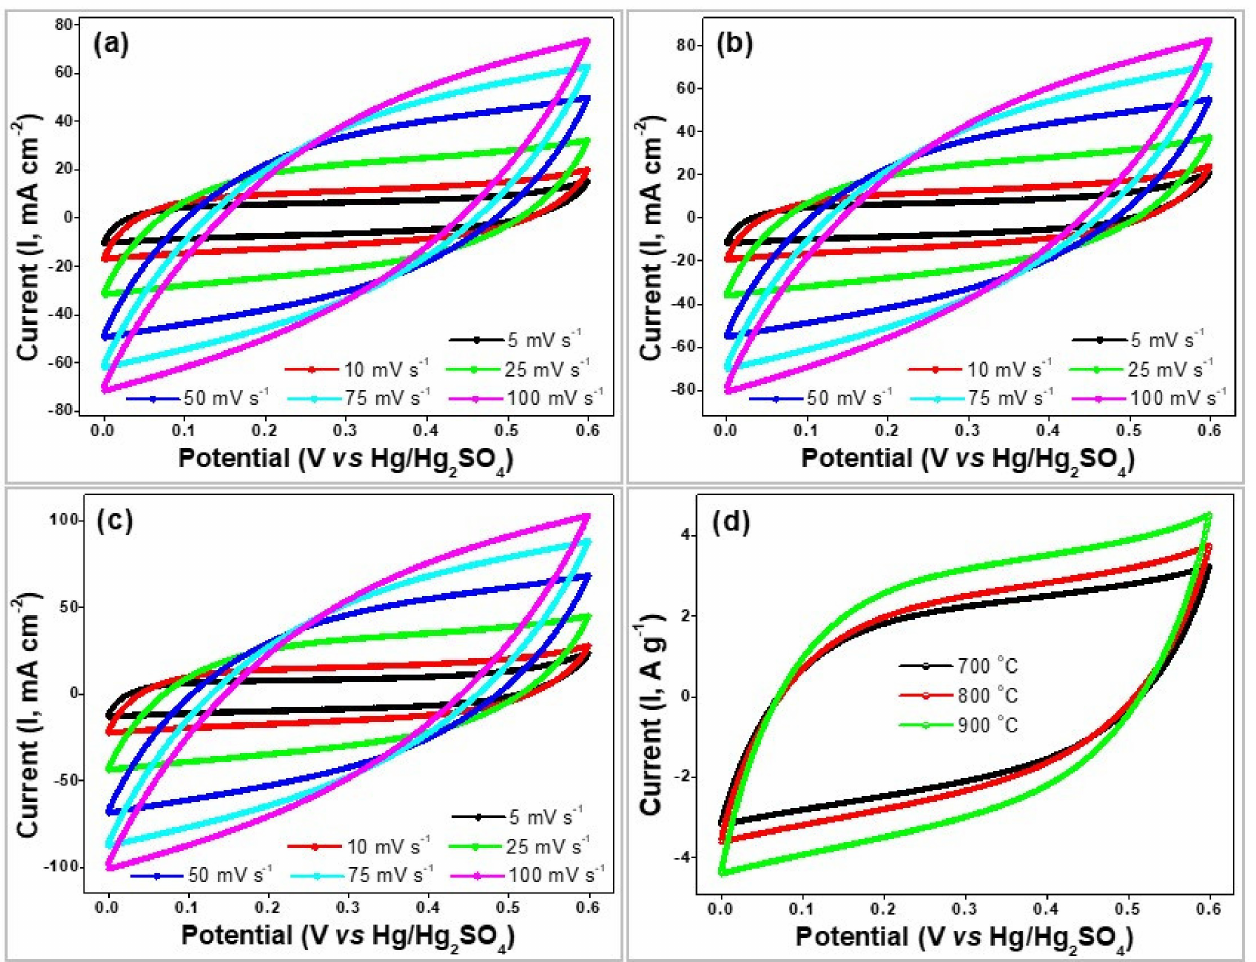
Figure 6. CV curves of NRPCs with different scan rates ( a ) NRPC-700, ( b ) NRPC-800, ( c ) NRPC-900 and ( d ) CV curves of NRPCs at a scan rate of 25 mV s − 1